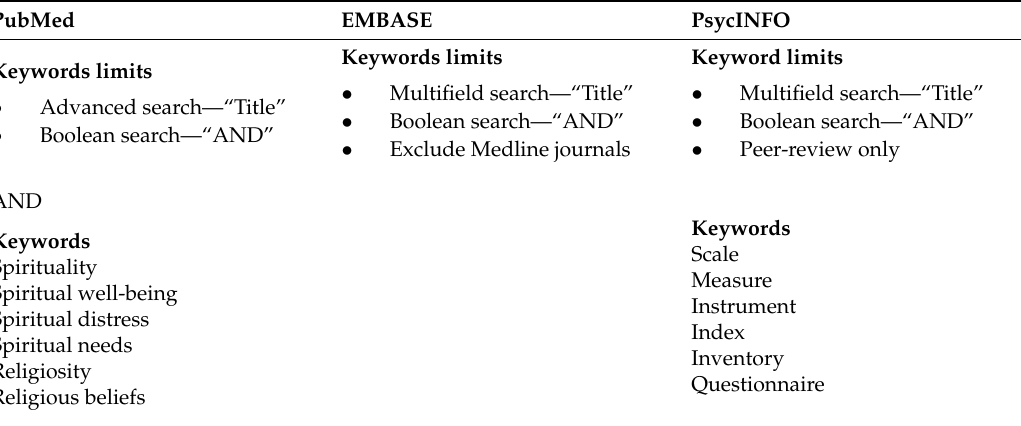
Table 1 . Keywords used in the location of articles investigating the use of measures beliefs.